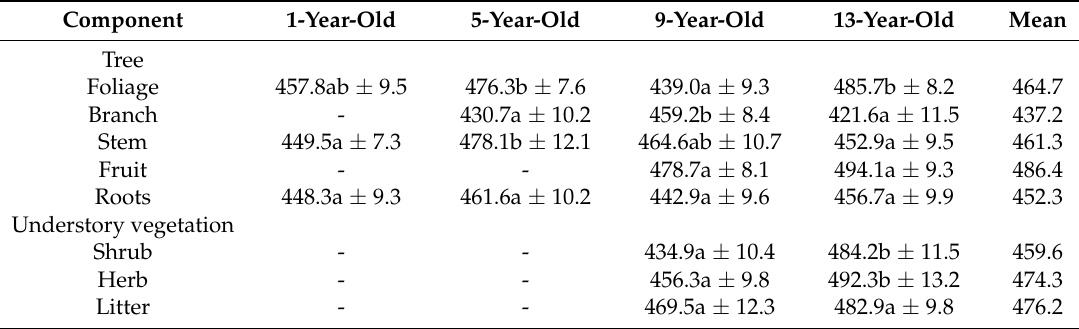
Table 3. Carbon concentration (g kg − 1 ) in trees, understory vegetation, and litter for 1-, 5-, 9-, and 13-year-old J. regia plantations ( n =